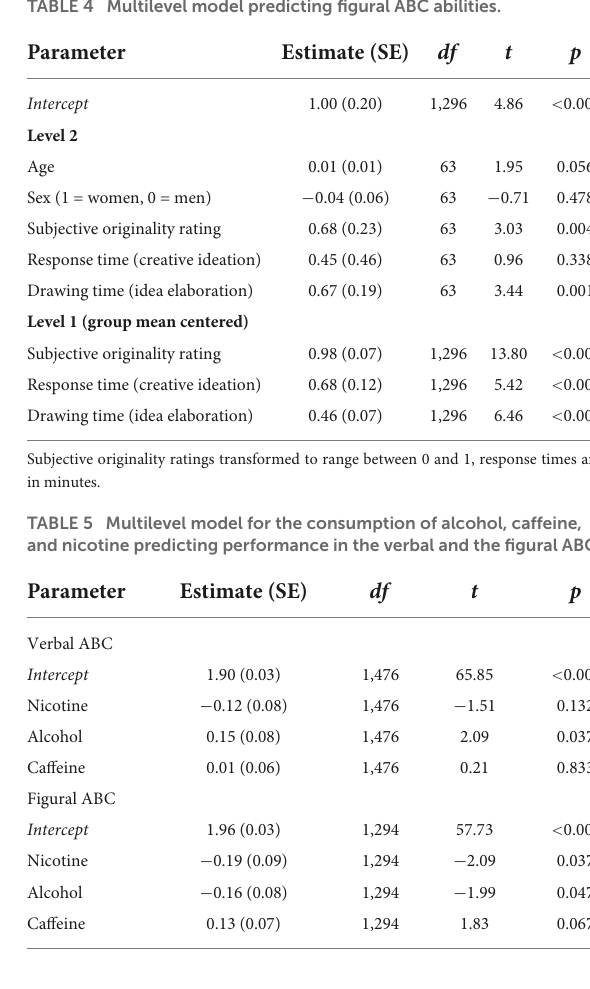
TABLE 4 Multilevel model predicting figural ABC abilities.